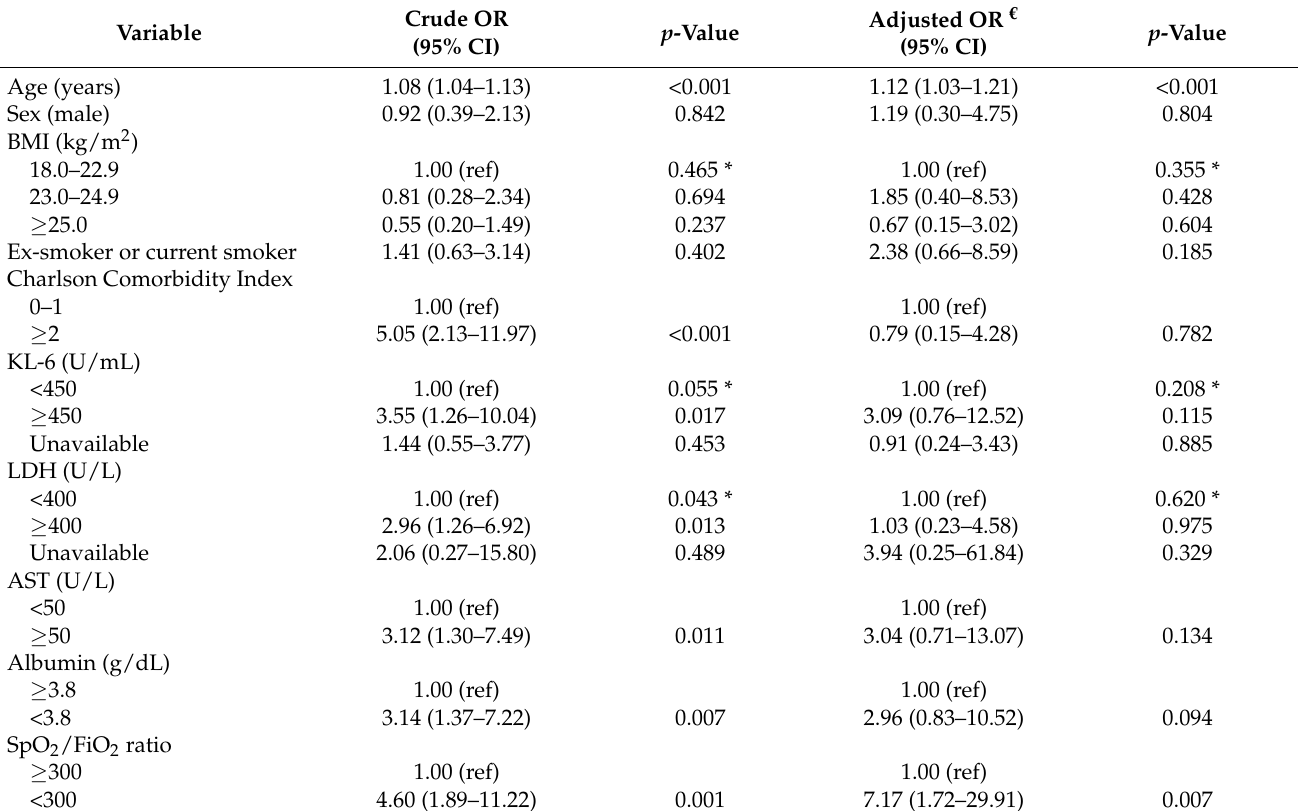
Table 3. Multivariate regression analysis for independent risk factors for post-COVID-19 fibrosis.